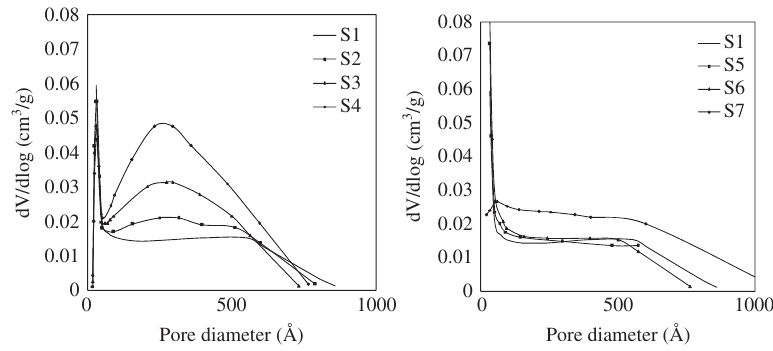
Figure 7 Pore-diameter distribution of artifically mixed soil and silt samples.